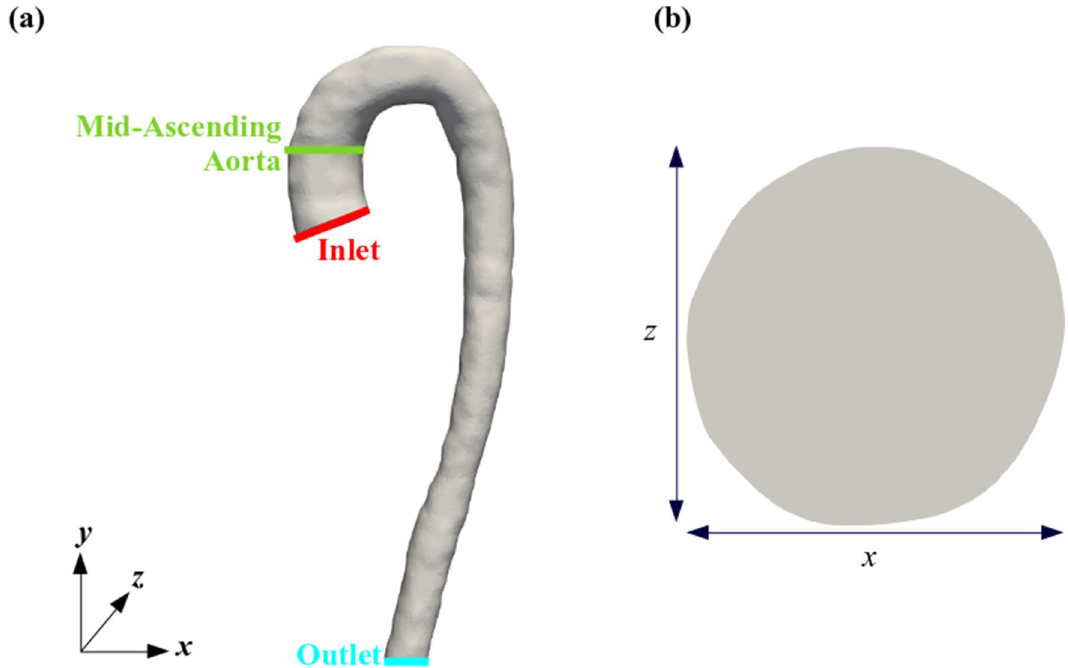
Figure 2. Location of the inlet, outlet, and plane of interest in the mid-ascending aorta for the patient used in this study ( a ), and the cross-section of the aorta in the mid-ascending aortic plane ( b